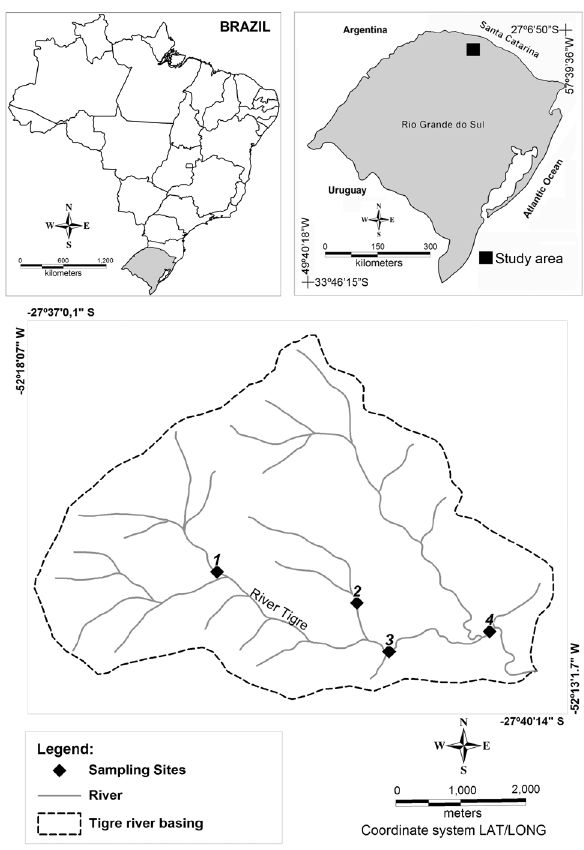
Figure 1. Geographic location of the collection sites by the Tigre River, Erechim, RS,